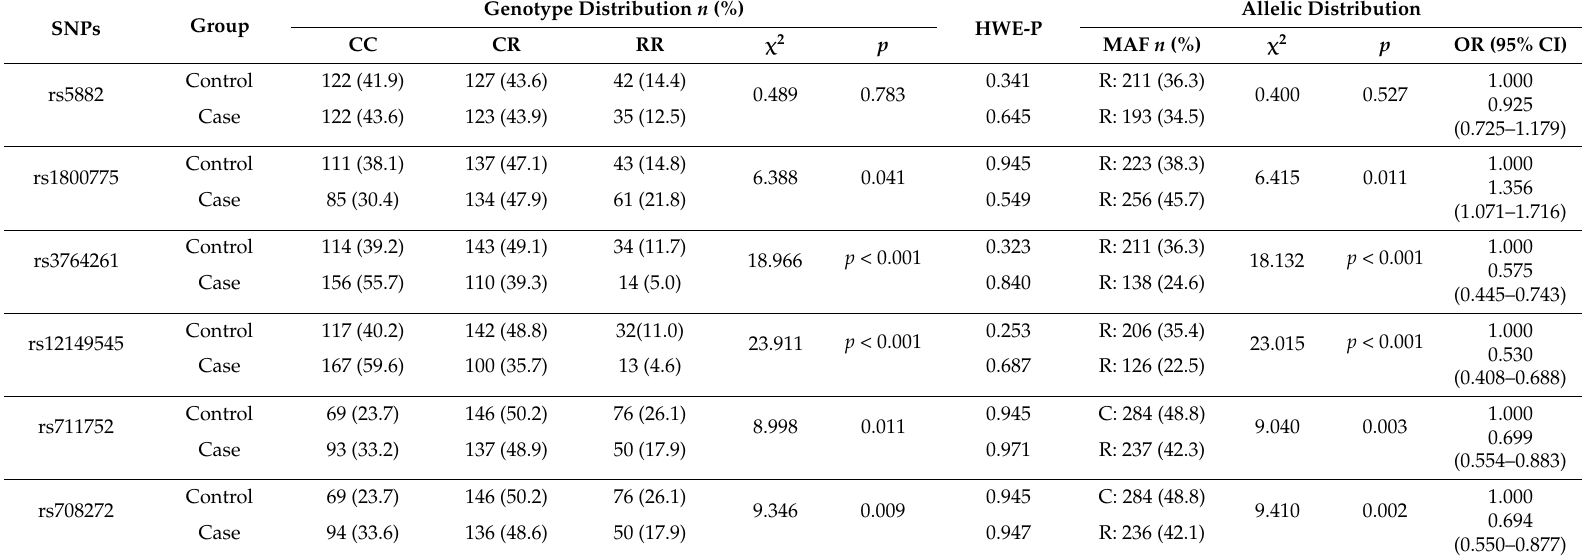
Table 3. Genotype and allele frequencies for the six CETP SNPs between control and case group and Hardy–Weinberg equilibrium